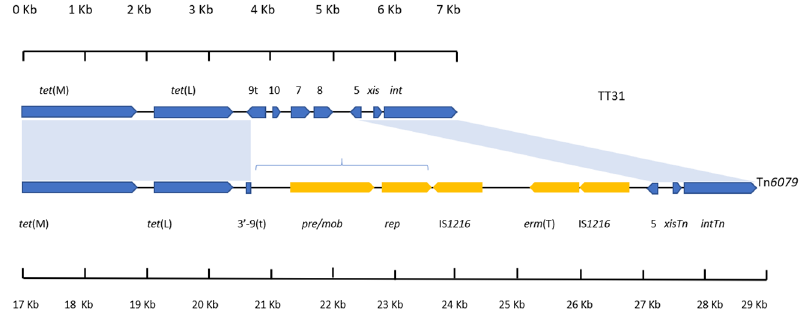
Figure 3. An alignment between the left 7226 bp of TT31 and the right 11,701 bp of Tn 6079 . Regions of Tn 6079 and TT31 that aligned are indicated by the blue shaded areas. Individual scales accompany each gene schematic. tet (M) and tet (L) are present in both as are orf5 , xisTn and intTn . orf9, orf10, orf7 and orf8 are not present on Tn 6079 . The pre / mob , rep and erm (T) genes (the latter of which is flanked by IS 1216 sequences) that are encoded by Tn 6079 are not present on TT31 and are highlighted in yellow. The region of Tn 6079 highlighted by blue brackets is present in the L. johnsonii BS15 genome also.